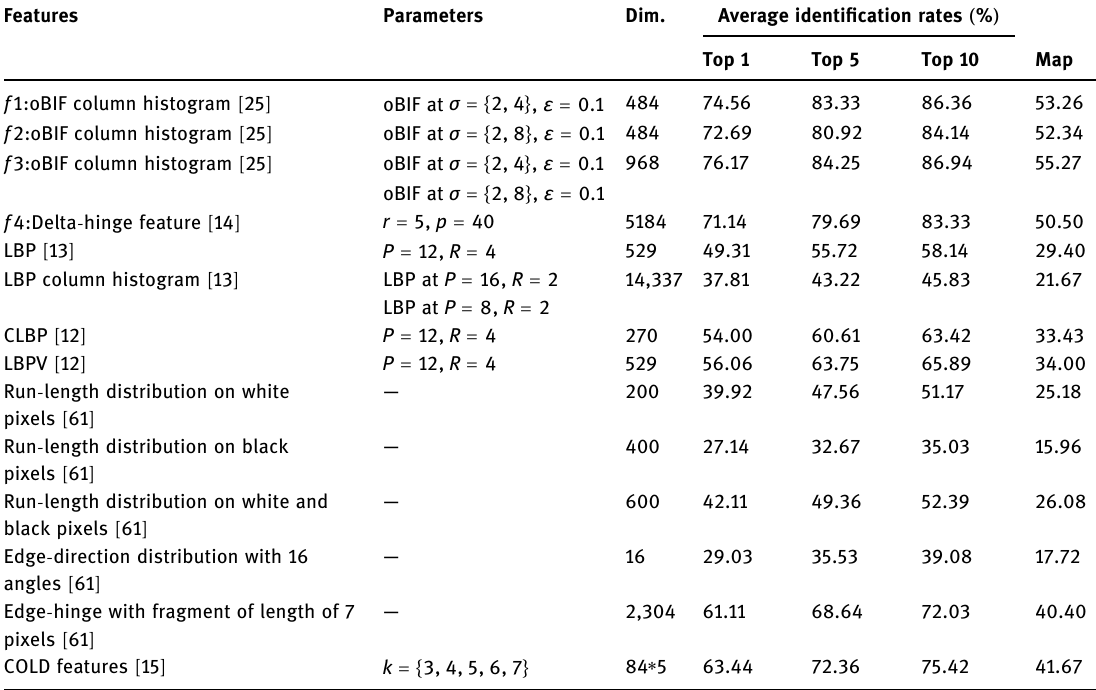
Table 2: Performance of well - known hand - crafted features using correlation distance